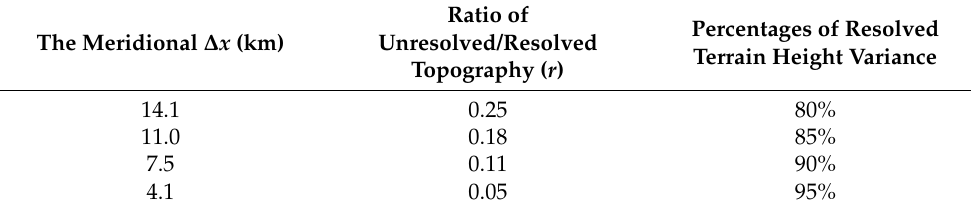
Table 5. The same as in Table 4, but for R2. n ∆ x = 133.6 km and δ x = 0.093 km.